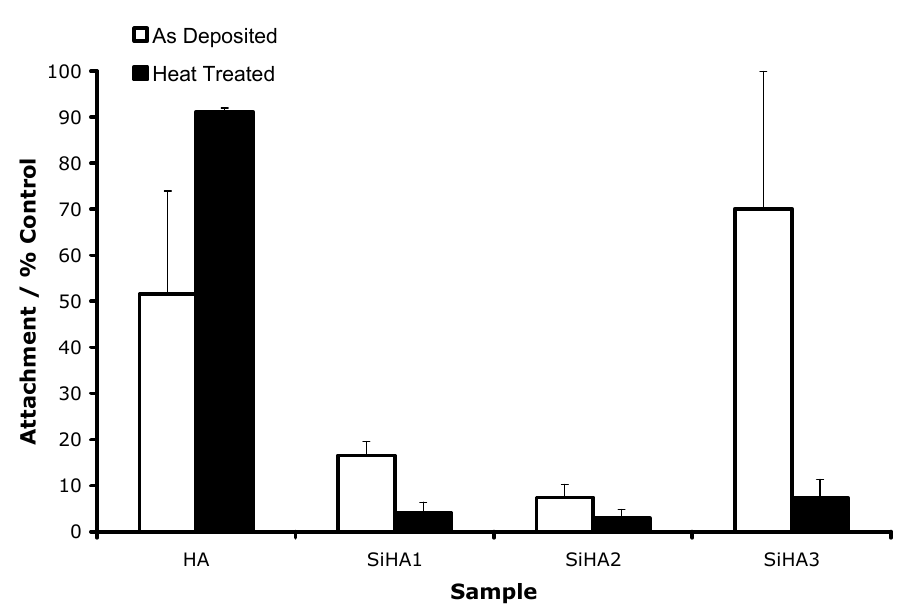
Figure 11. The 90 min attachment of HOB cells to as deposited and heat treated HA and SiHA films at 600 °C. Values are mean ± standard error where n = 6.